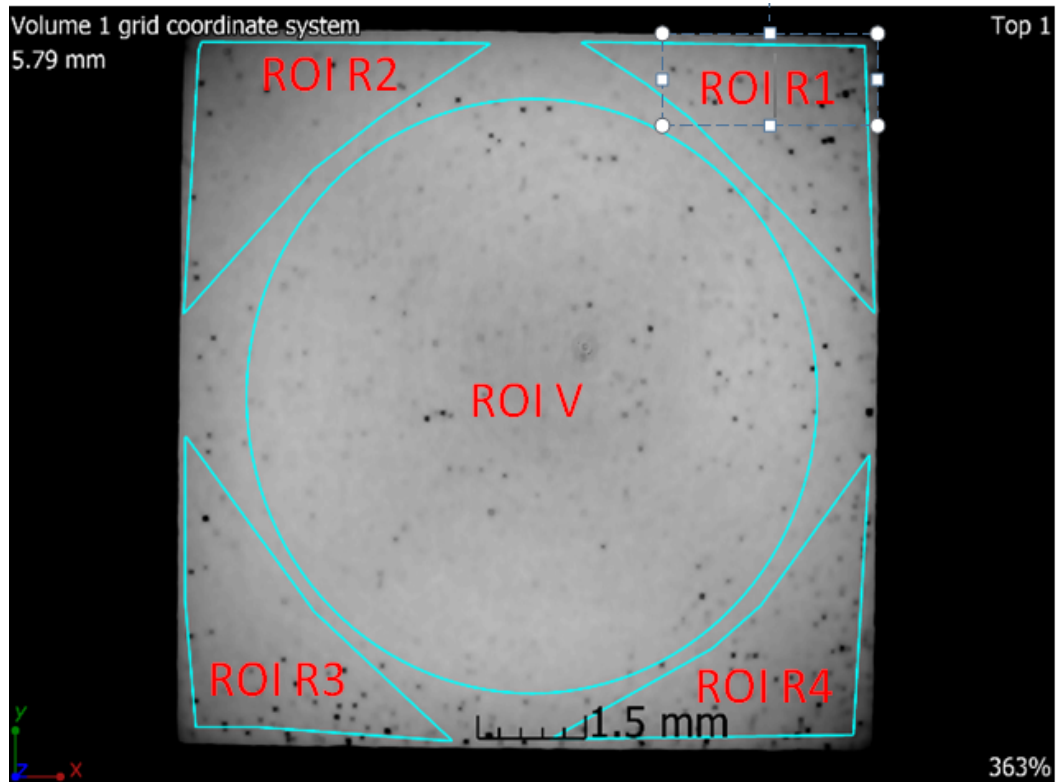
Figure 20. Tomographic CT sections of sample 5 with an adaptive Gaussian filter.